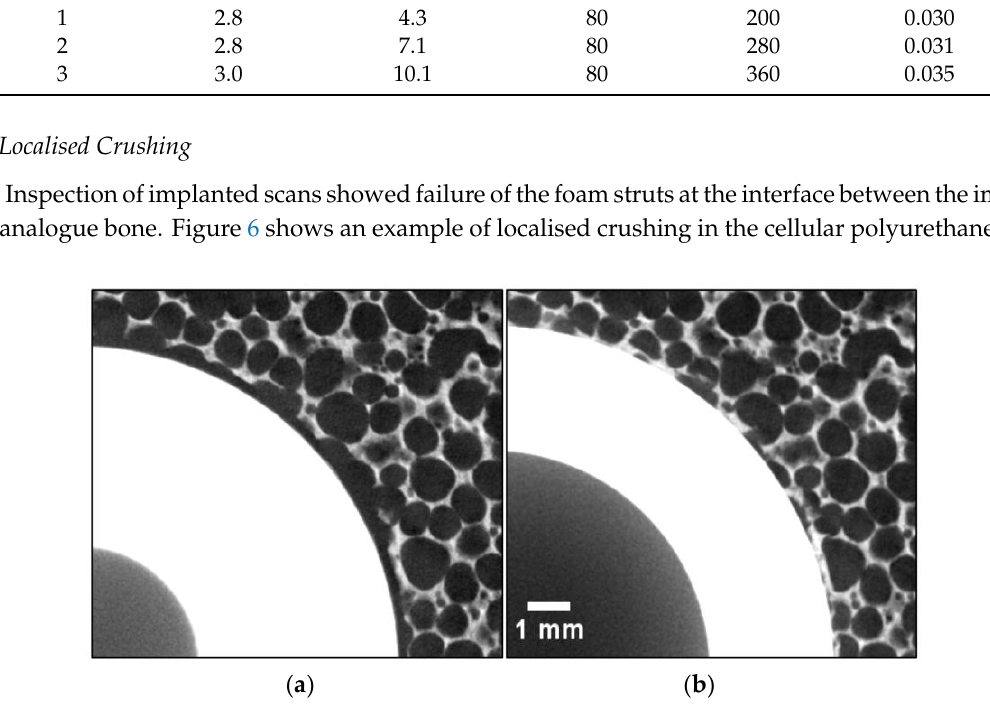
Figure 6. Localised crushing of foam struts: ( a ) before implantation; ( b ) after implantation. Note, the scale is the same for both images.